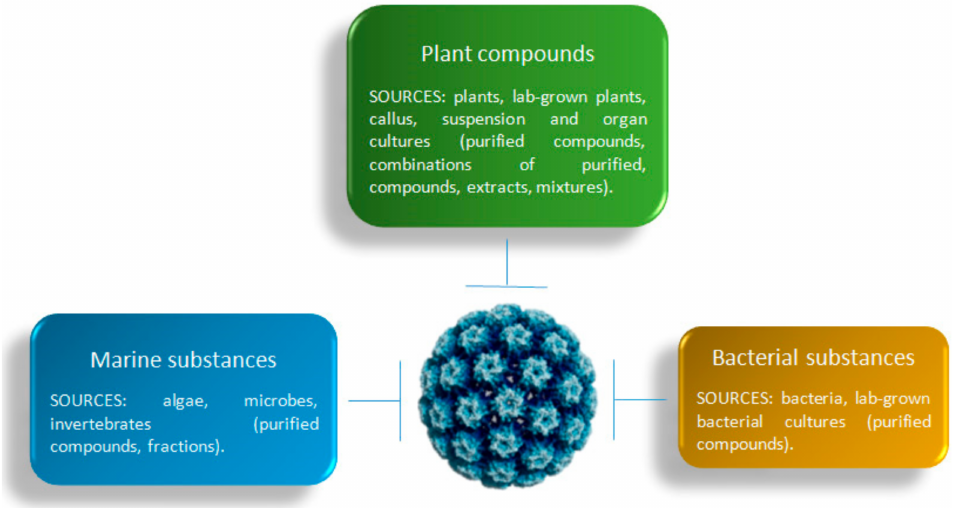
Figure 1. Sources (plants, marine environment, bacteria) and nature (purified compounds and their combinations, fractions, extracts, mixtures) of formulations that have been investigated against